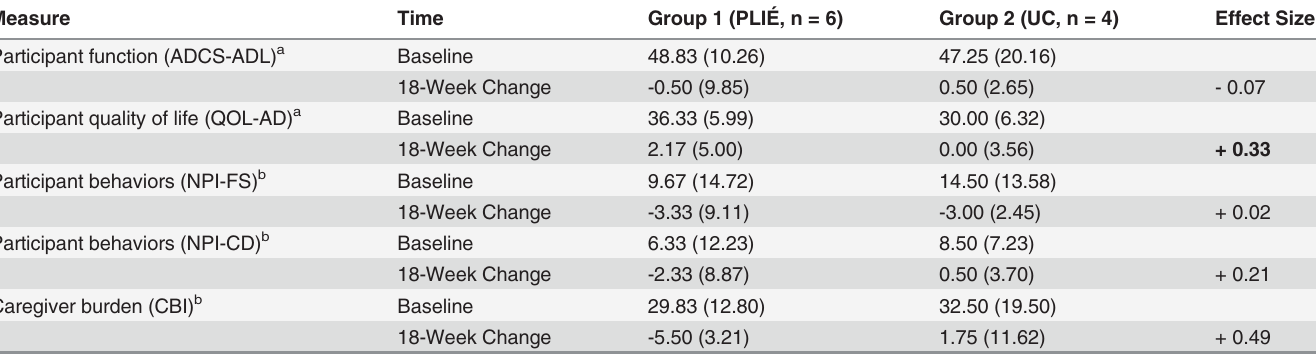
Table 4. Between-Group Change in Caregiver Measures * , Baseline to 18